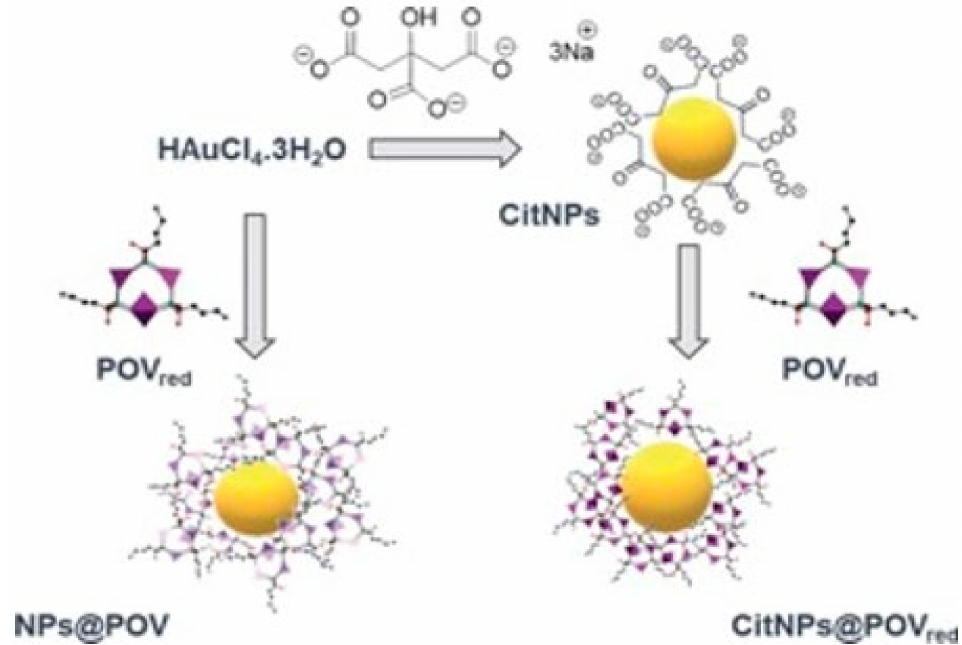
Figure 10. Schematic representation of CitNPs, CitNPs@POVred and NPs@POV synthesis, reprinted with consent from reference [94], RSC,